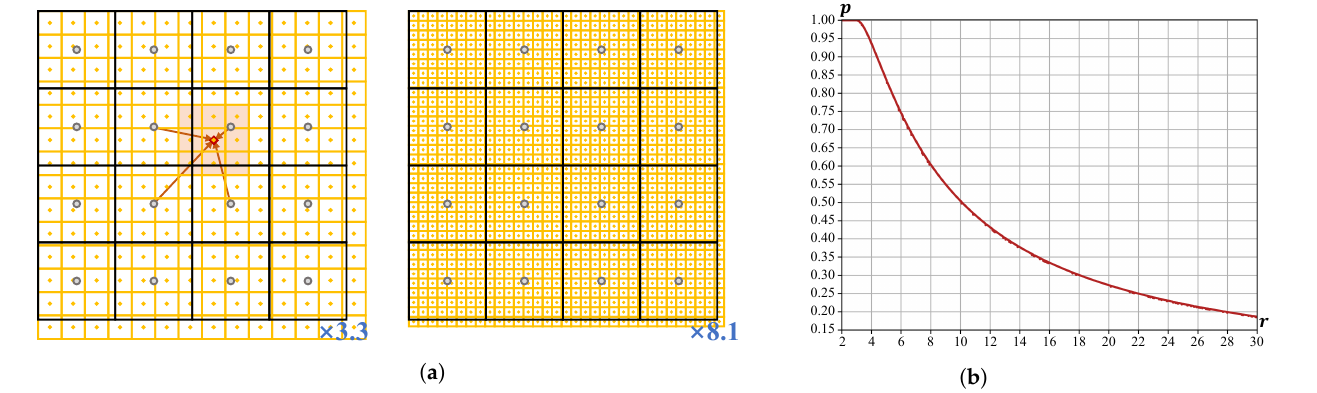
× 3.3 Figure 4. The sparsity of the latent code at different scale factors. Figure ( a ) shows the density of the LR coordinates compared to the HR spatial coordinates at scale factors of 3.3 and 8.1. The sparsity index ψ is calculated in Figure ( b ) to demonstrate the density of the latent code at different resolutions.